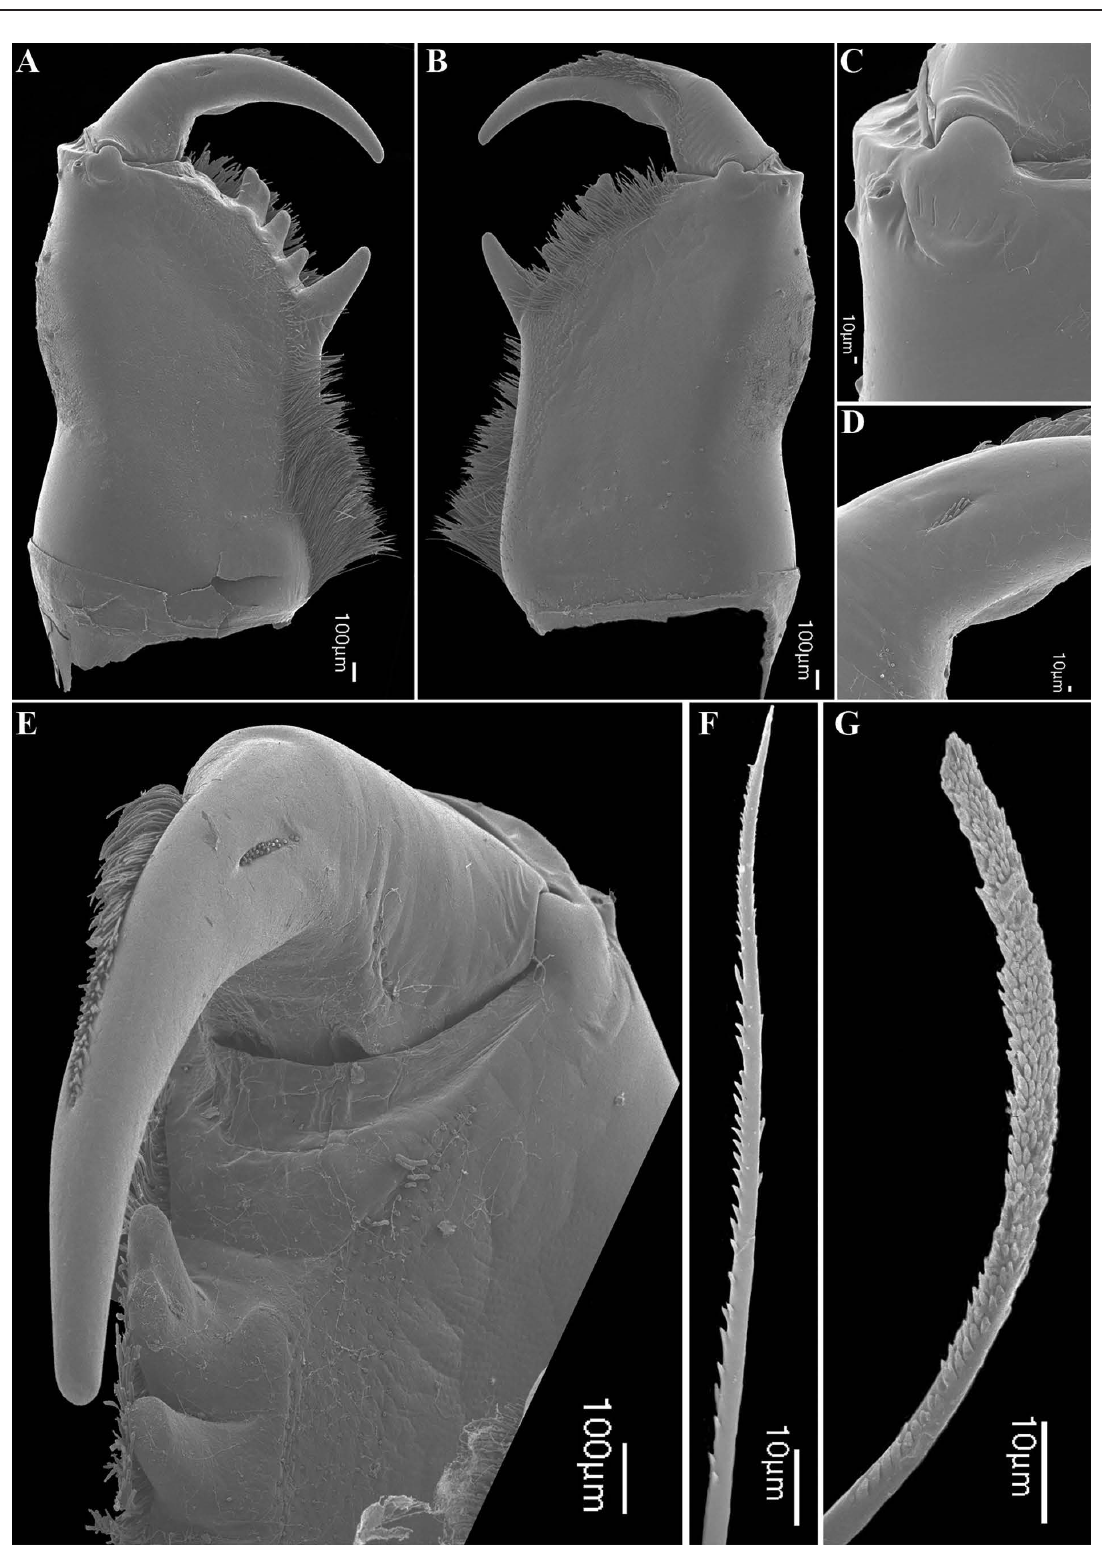
Fig. 39. Charinus insularis Banks 1902 (RBINS), chelicerae. A . Retrolateral view. B . Prolateral view. C . Slit sensillae on lateral surface of basal segment. D . Dorsal patch of setae on claw. E . Cheliceral claw and proximal teeth of basal segment, frontal view. F . Seta on basal segment. G . Seta on prolateral surface of